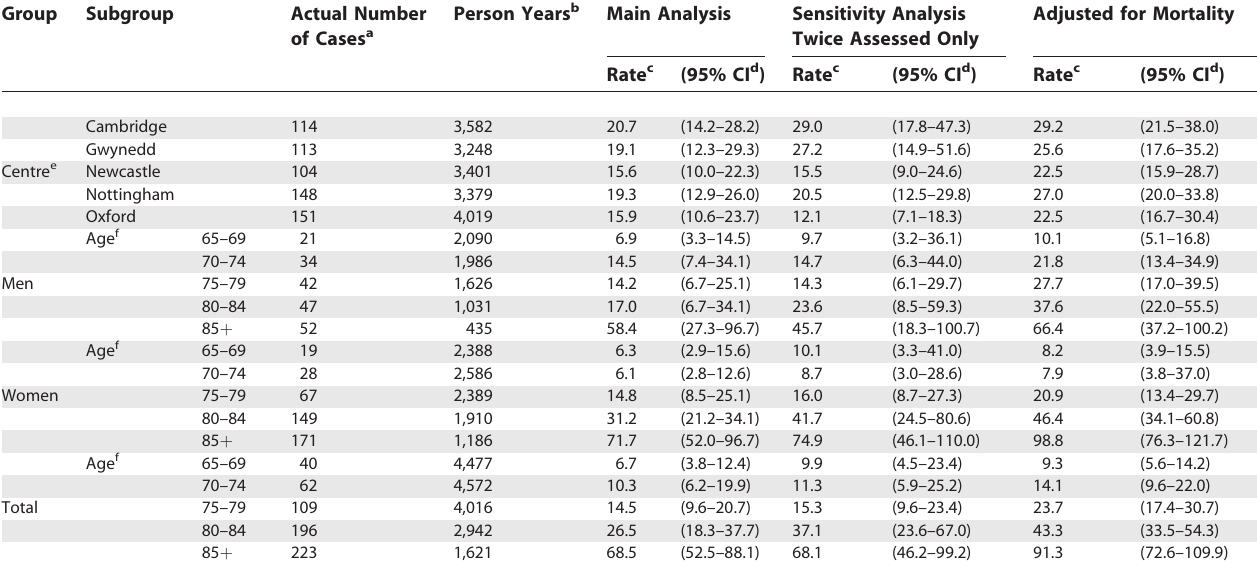
Table 3. Number of Cases, Person Years, and Incidence Rate per 1,000 Person Years with 95% Confidence Interval Group Subgroup